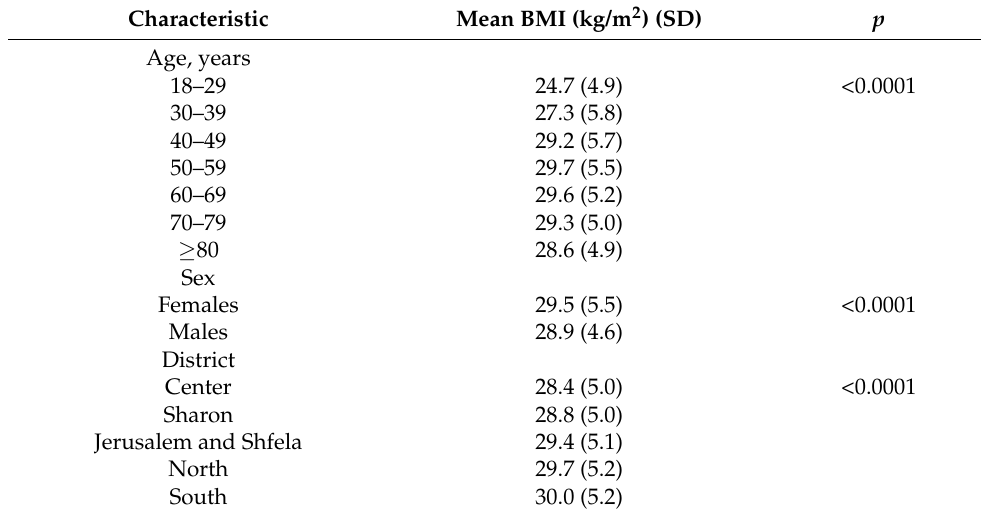
Table 2. Body mass index of 180,126 OA patients in 2018, by age, gender, and district.